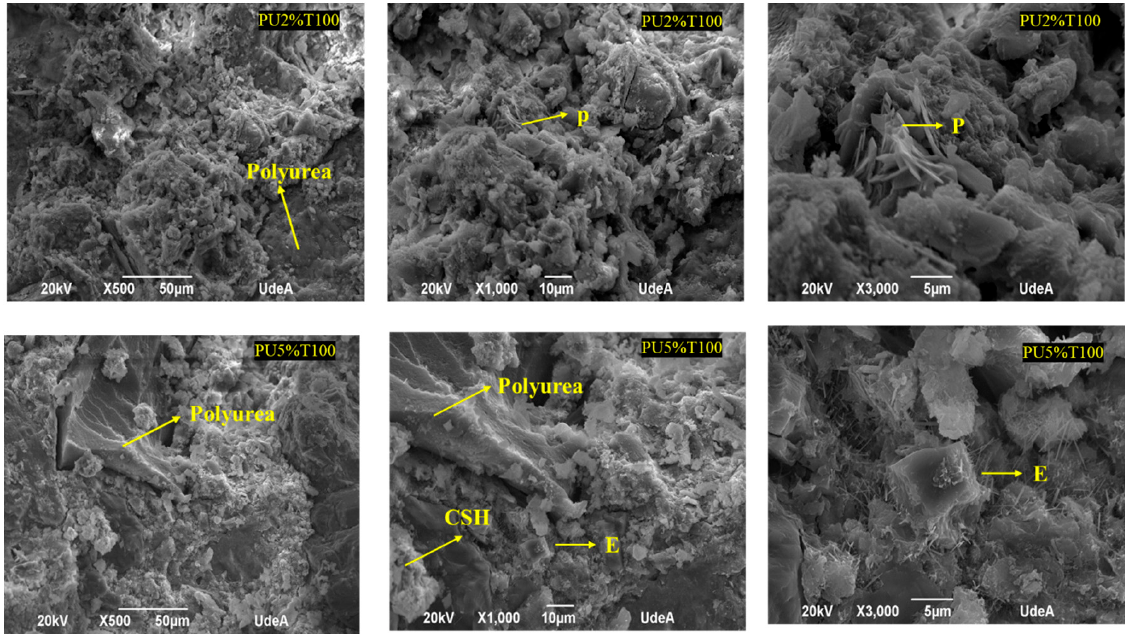
Figure 7 . SEM analysis of mortars with polyurea retained in sieve 100 (PU2%T100 and PU5%T100).